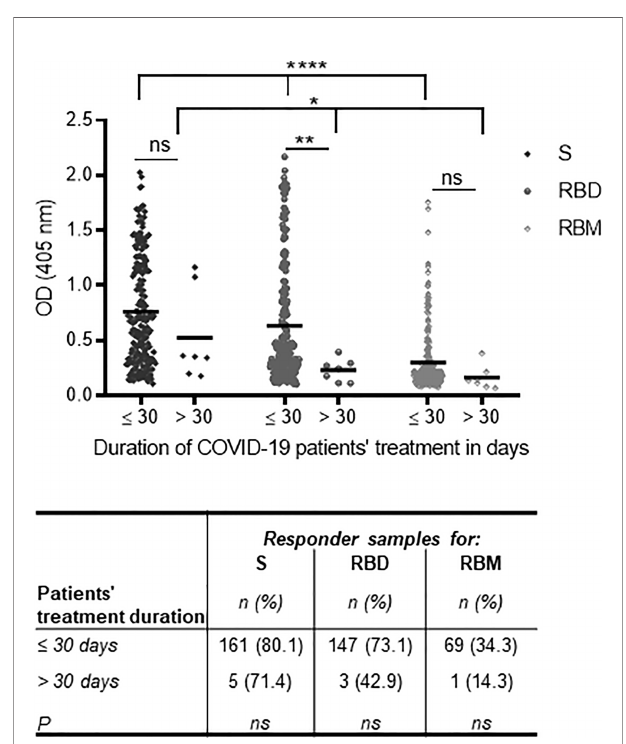
FIGURE 5 | Association of anti-S, receptor-binding domain (RBD), and receptor-binding motif (RBM) antibodies at the time of hospital admission with the duration of treatment for symptomatic COVID-19. The lowest antibody levels for S, RBD, and RBM at the time of hospital admission were associated with increased patient treatment time for symptomatic forms of COVID-19 (i.e., >30 days) as shown in the graph. The correlation was strongest with RBD recognition. The table shows the proportions of S, RBD, and RBM responders as a function of their treatment duration, but no signi fi cant difference was observed between the three antigens and the treatment duration time. The unpaired t-test and ANOVA were used to compare the mean Ab optical density (OD) between the two treatment duration groups and between antigens, respectively, and Fisher ’ s exact test was used to determine the proportion of responders with a treatment duration of ≤ 30 or >30 days. * p < 0.05; ** p < 0.01; **** p < 0.0001. ns, not signi fi